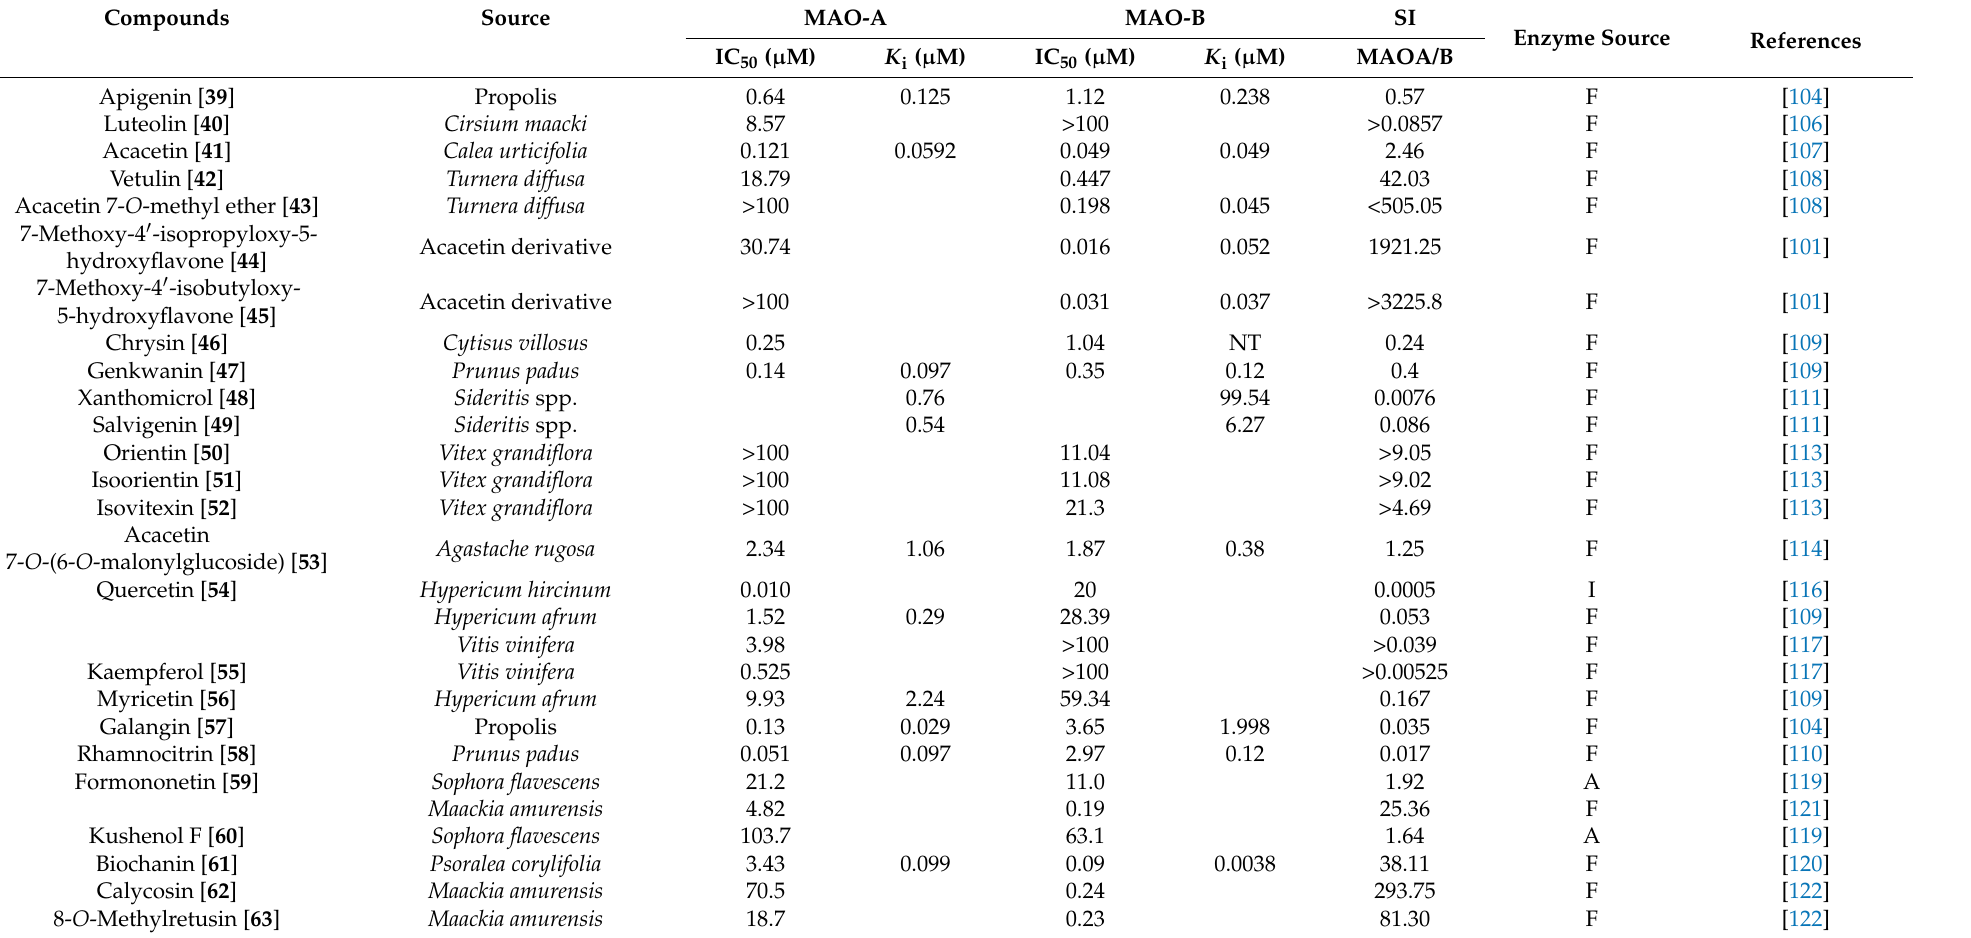
Table 3. Flavonoid natural product inhibitors of MAO-A and